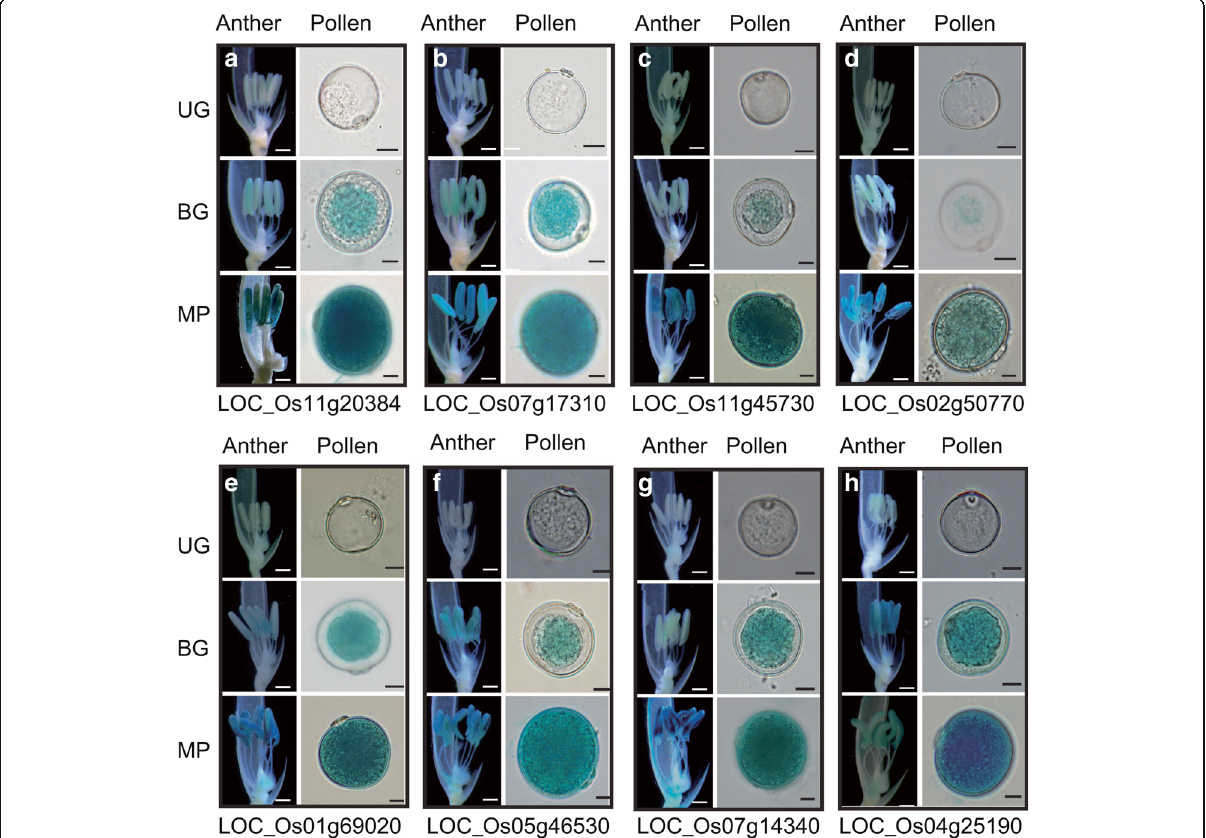
Fig. 2 Evaluation of late pollen-preferred genes using GUS reporter systems. Images of flower and pollen from promoter trap lines 1A-13,819 having T-DNA insertion within LOC_Os11g20384 ( a ) and 2D-41,188 harboring T-DNA insertion within LOC_Os07g17310 ( b ) at sequential stages of pollen development. Images of flower and pollen from transgenic plants harboring promoter:: GUS reporter constructs. Promoters from LOC_Os11g45730 ( c ), LOC_Os02g50770 ( d ), LOC_Os01g69020 ( e ), LOC_Os05g46530 ( f ), LOC_Os07g14340 ( g ), and LOC_Os04g25190 ( h ) were used to control GUS expression. BG, bi-cellular gametophyte stage; MP, mature pollen stage; UG, uni-cellular gametophyte stage. GUS expression patterns were used from promoter trap lines and promoter- GUS transgenic lines. Bar in flower image=0.5 mm; bar in pollen image=10 μ